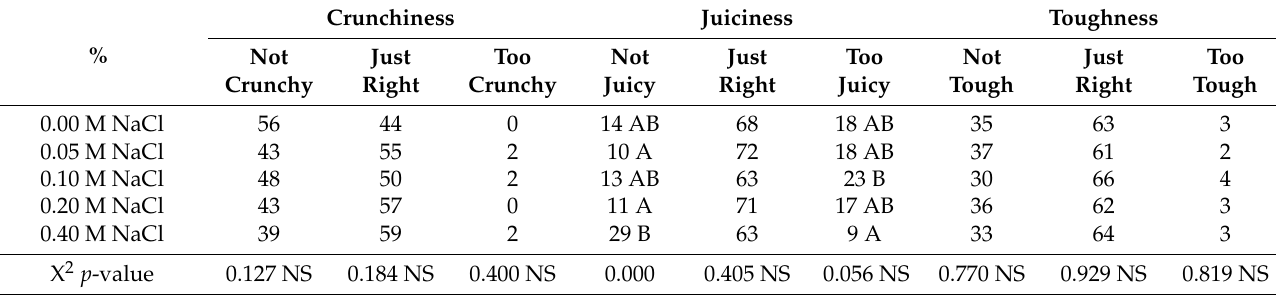
Table 3. Frequency counts (%) on 5-point just about right (JAR) scale of crunchiness, juiciness, and toughness intensity of ice plant in response to sodium chloride (NaCl) treatment in hydroponic nutrient. Same letters represent statistically significant groups that are different from each other based on k proportion test (alpha = 0.05). Bold = statistically significant at 95%; NS = not statistically significant at 95% Level of Confidence.